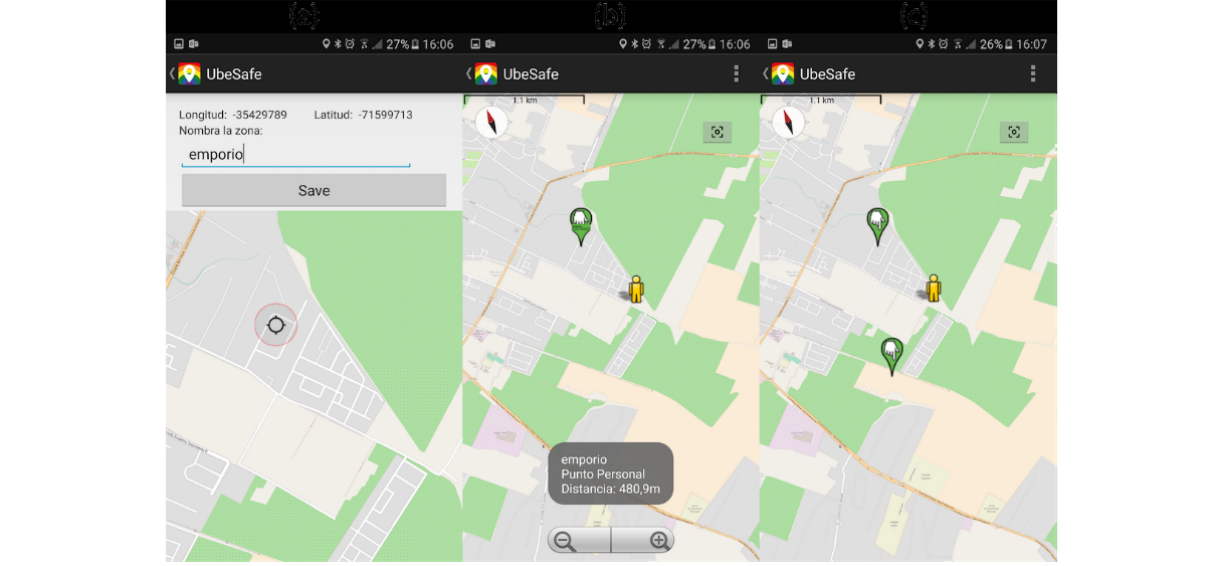
Figure 4. UBESAFE—Android client: adding users’favorite hot zones for future monitoring of the alert service.